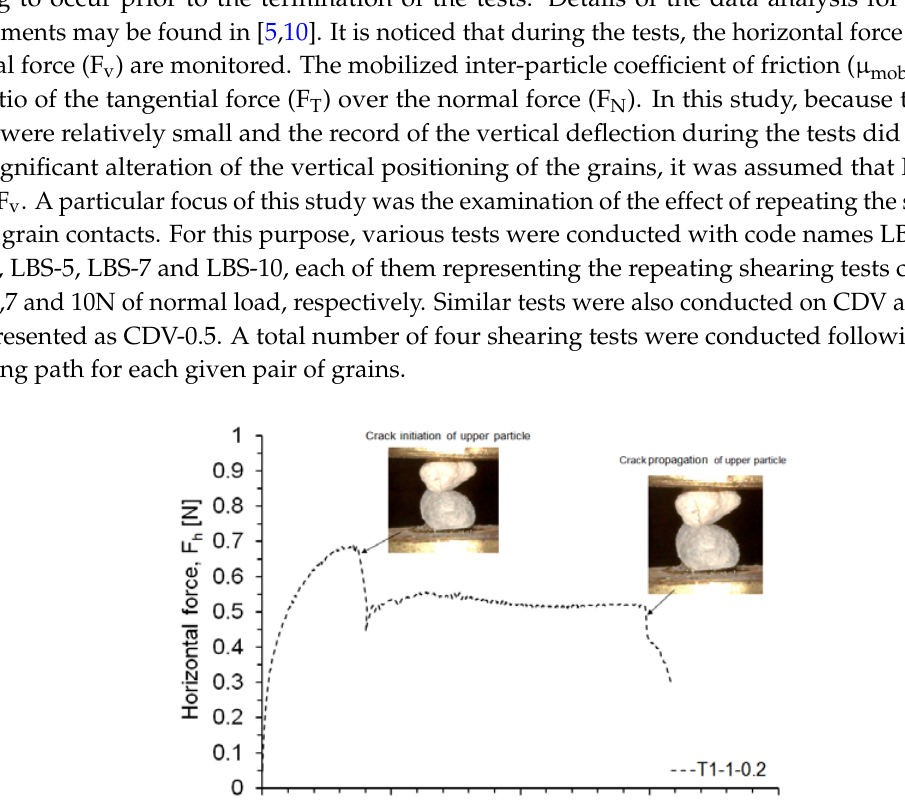
Table 1. Micro-mechanical sliding testing program and summary of results.